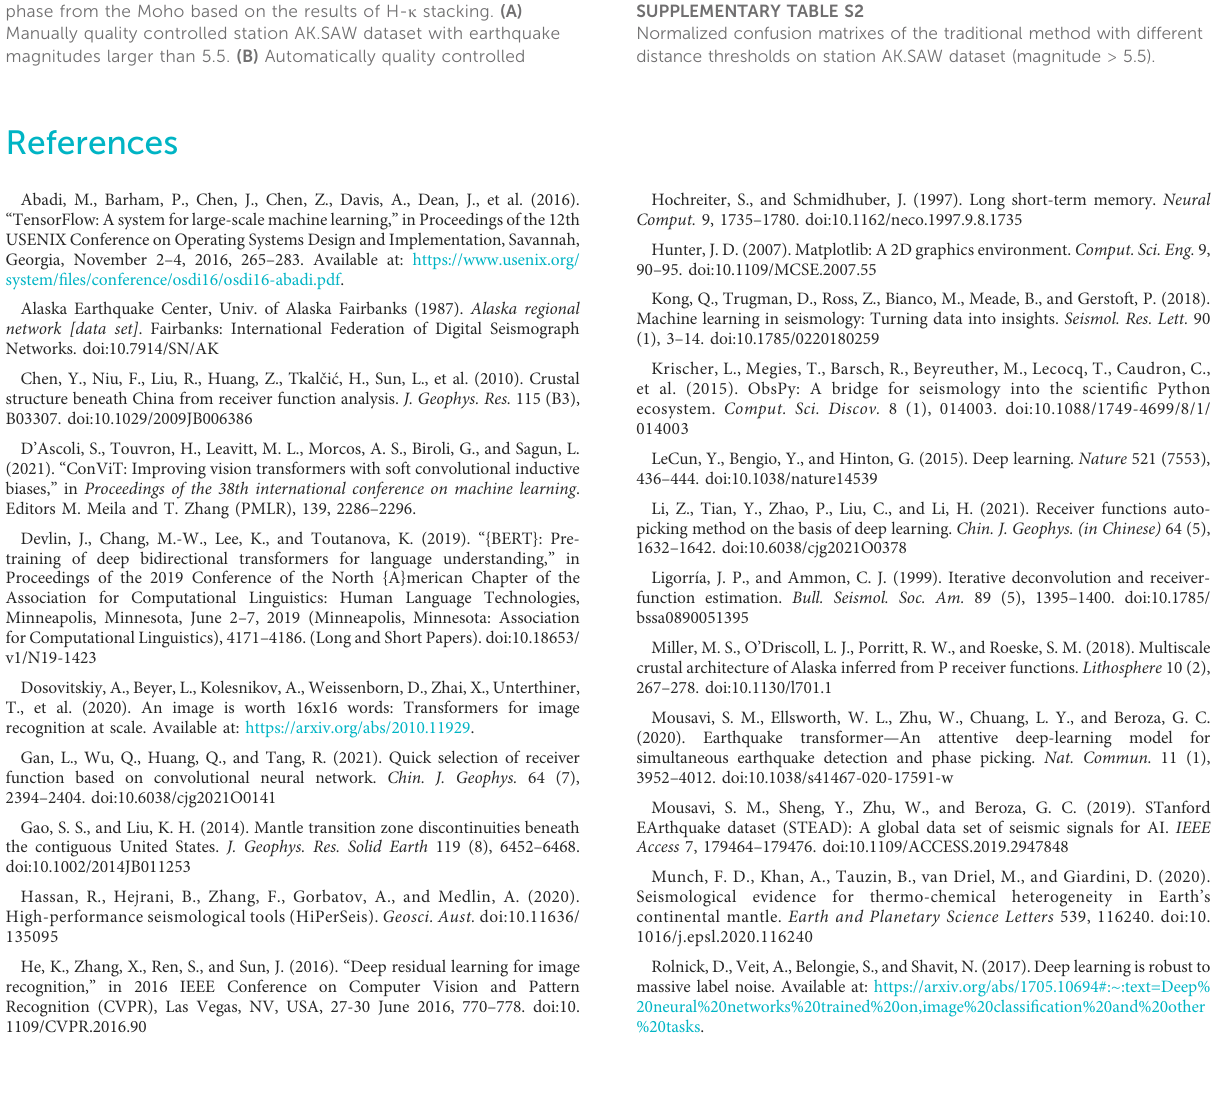
SUPPLEMENTARY FIGURE S7 The receiver function waveforms from station IC.QIZ around a polar plot with the source direction. Red lines are the average waveforms of many similar waveforms inback-azimuth bins. (A) Manually quality controlled dataset containing 771 receiver functions with earthquake magnitudes larger than 5.5. (B) Automatically quality controlled dataset by the CNN- BiLSTM model containing 686 receiver functions with earthquake magnitudes between 5.0 and 5.5. (C) Automatically quality controlled dataset by the traditional method in HiPerSeis containing 74 receiver functions with earthquake magnitudes between 5.0 and 5.5. SUPPLEMENTARY FIGURE S8 The receiver function waveforms from station CB.CAD around a polar plotwiththesourcedirection.Redlinesaretheaveragewaveformsofmany similar waveforms in back-azimuth bins. (A) Manually quality controlled datasetcontaining964receiverfunctionswithearthquakemagnitudeslarger than 5.5. (B) Automatically quality controlled dataset by the CNN-BiLSTM model containing 458 receiver functions with earthquake magnitudes between 5.0 and 5.5. (C) Automatically quality controlled dataset by the traditional method in HiPerSeis containing 265 receiver functions with earthquake magnitudes between 5.0 and 5.5. SUPPLEMENTARY FIGURE S9 Stacked receiver functions against the epicentral distance. Grey lines show the theoretical arrival times of the converted phase and multiple phase from the Moho based on the results of H- κ stacking. (A) Manually quality controlled station AK.SAW dataset with earthquake magnitudes larger than 5.5. (B) Automatically quality controlled